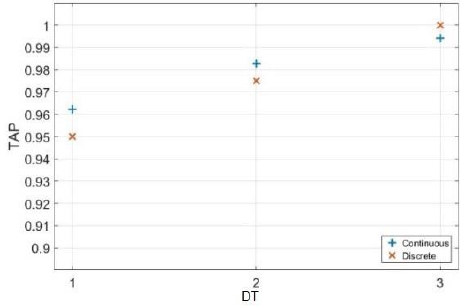
Figure 6. Continuous and discrete adjustment of taps, 0% PV.